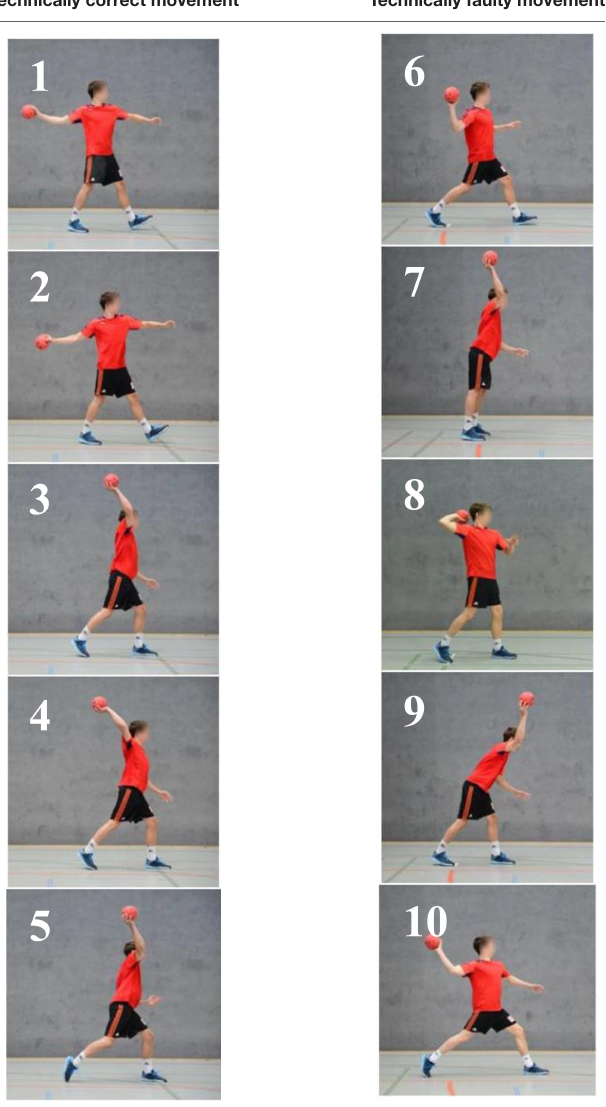
TABLE 1 | The images used represent the BACs of the overhead throwing movement. Technically correct movement Technically faulty movement